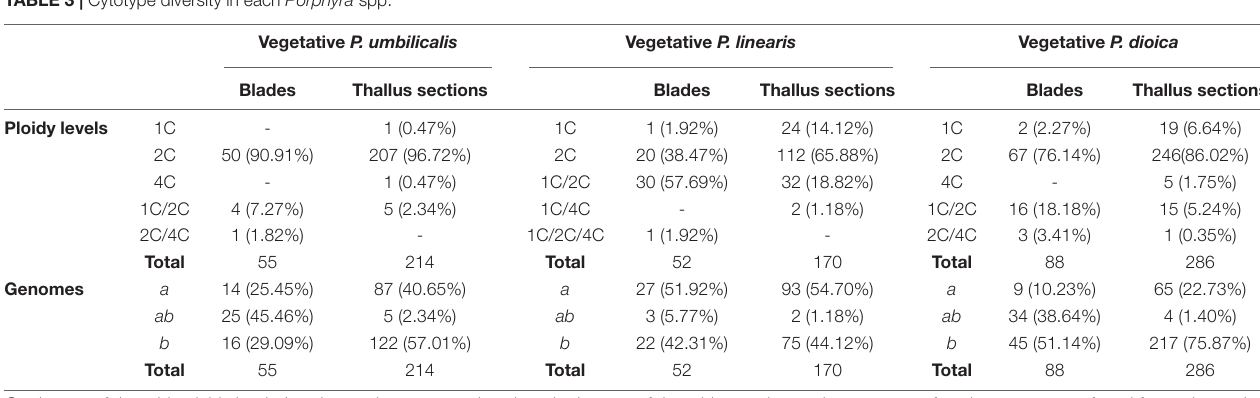
On the top of the table ploidy levels (number and percentages) and on the bottom of the table, number and percentage of each genome type found for each species. Values are given for entire blades (taking in account the 3 times re-sampling) and for the total amount thallus portions measured (independently of how many blades were measured) in each